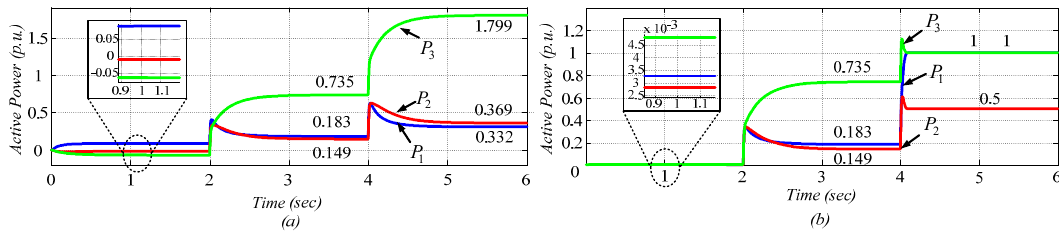
Figure 9. Variations of active power with the scheme of ( a ) without modification; and ( b ) with modification.